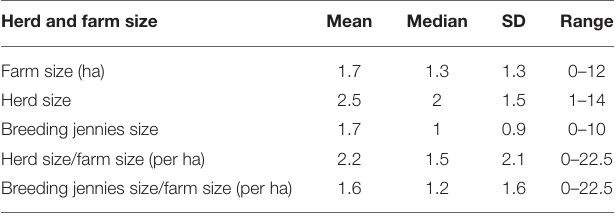
TABLE 4 | Characteristics of the stables across smallholder farms in Western Liaoning and Eastern Inner Mongolia of China ( n = 731).